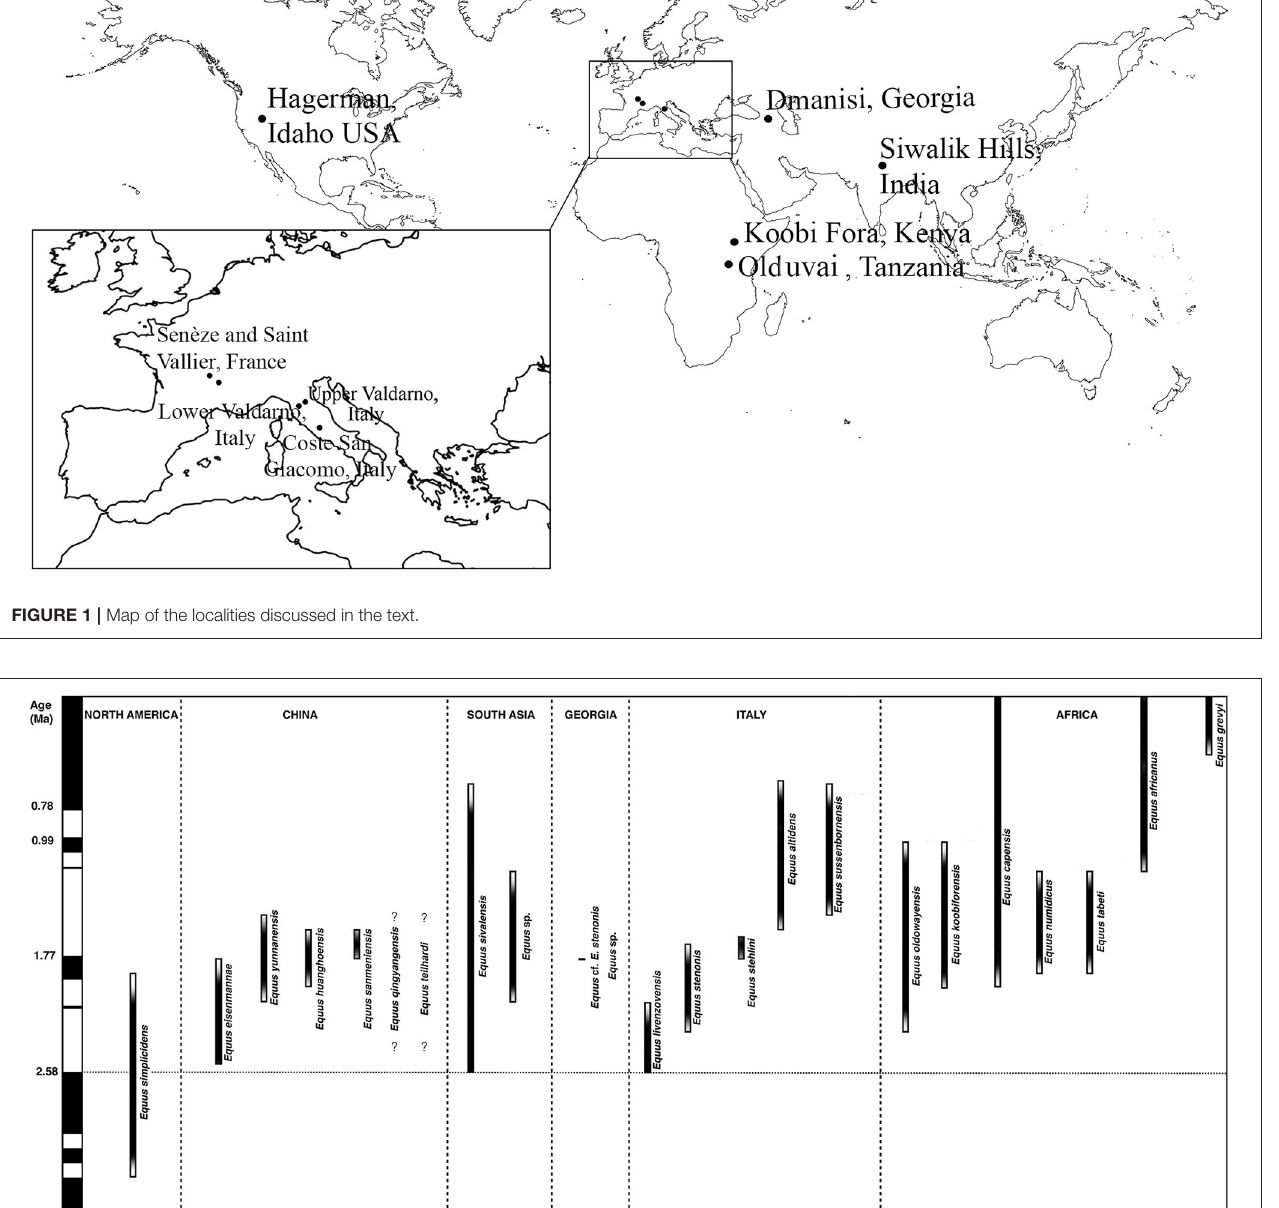
at Livensovka near Rostov on Don (Bajgusheva, 1971, 1978). Azzaroli (1982) noted that the skulls of Equus livenzovensis are somewhat larger than E. namadicus and E. stenonis , but otherwise similar. Azzaroli (1982) has reported that the Khapry skull has a well developed preorbital fossa (POF). Bernor et al.